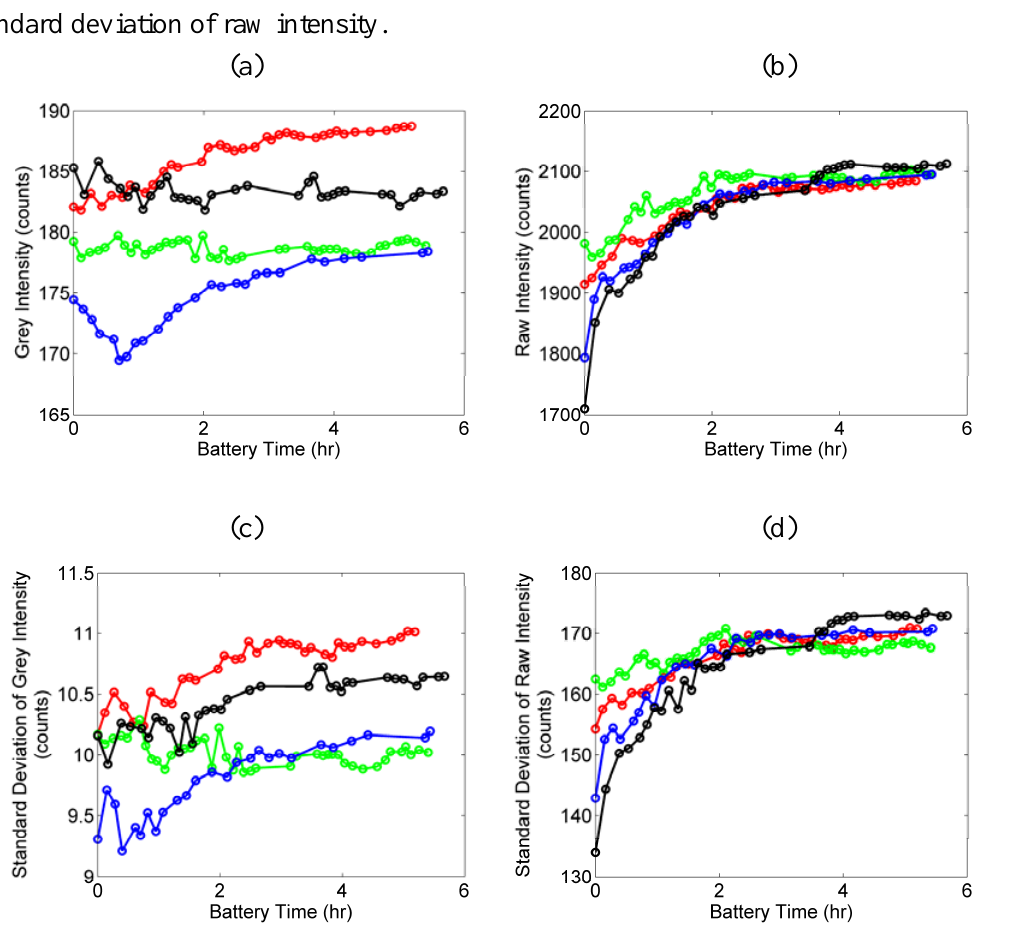
Figure 2. Time series of five complete scans of the battery experiment. (a) mean of grey intensity, (b) mean of raw intensity, (c) standard deviation of grey intensity, and (d) standard deviation of raw